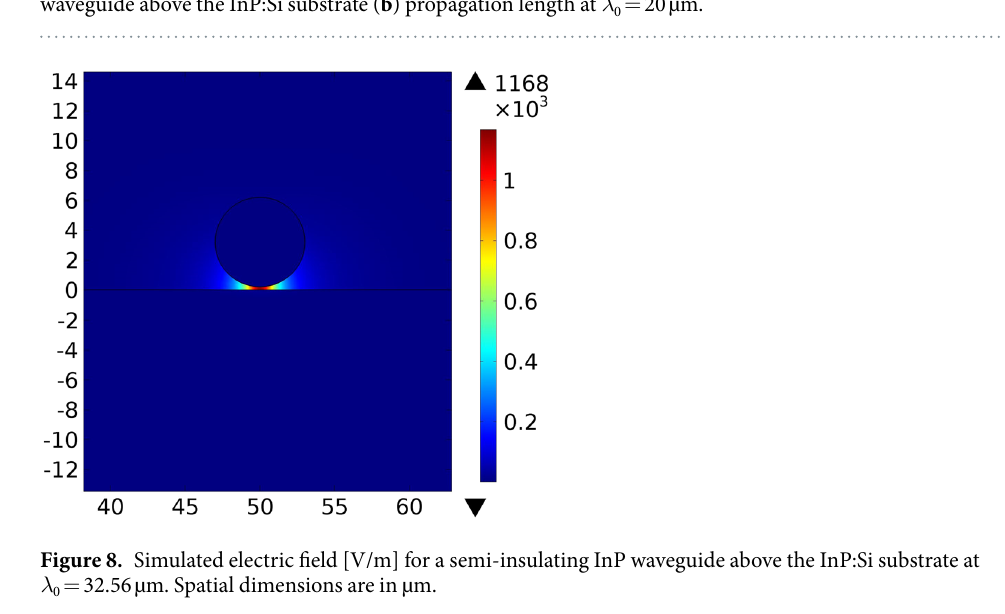
Figure 7. ( a ) Optical force versus waveguide’s diameter for different gap sizes for semi-insulating InP waveguide above the InP:Si substrate ( b ) propagation length at λ 0 = 20 µ m.